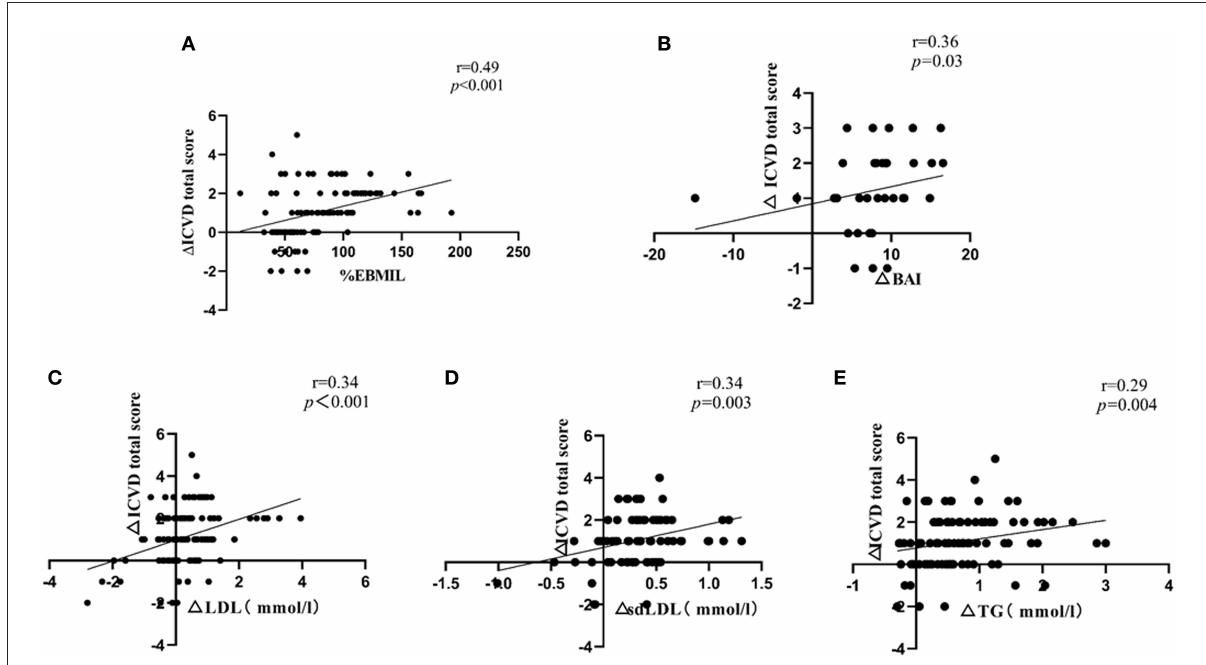
FIGURE3 (A) Correlation of 1 ICVD total score with %EBMIL; (B) Correlation of 1 ICVD total score with 1 BAI; (C) Correlation of 1 ICVD total score with 1 LDL; (D) Correlation of 1 ICVD total score with 1 sd-LDL; (E) Correlation of 1 ICVD total score with 1 TG. 1 values were obtained by subtracting the 6-month value from the pre-operative value; ICVD, ischemic cardiovascular disease; %EBMIL, percent excess body mass index loss; BAI, body adiposity index; LDL, low-density lipoprotein; sd-LDL, small dense-low-density lipoprotein; TG, triglyceride. N = 107, Spearman correlation analysis as a nonparametric measure was used to examine the relationships between 1 ICVD total score and %EBMIL, 1 BAI, 1 LDL, 1 sd-LDL, 1 TG.